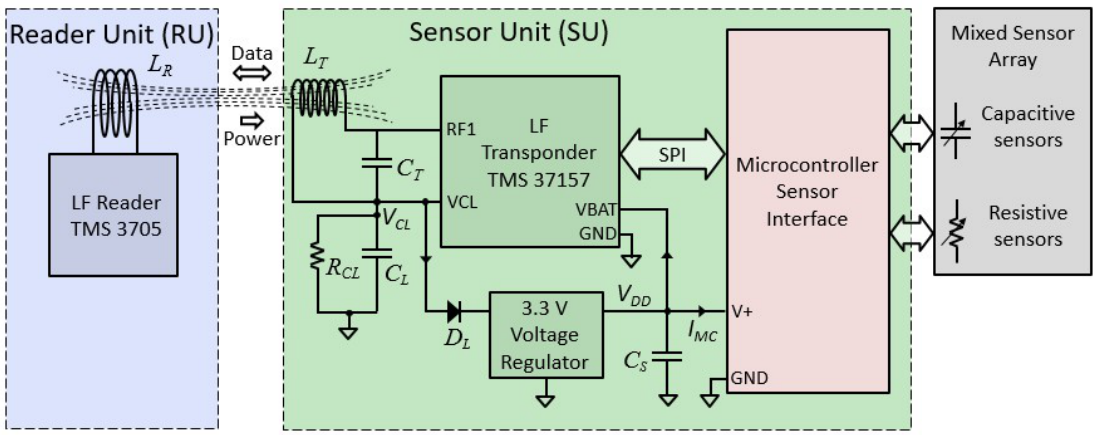
Figure 1. Block diagram of the radio-frequency identification (RFID) data and power transfer circuitry for capacitive and resistive mixed sensor array.